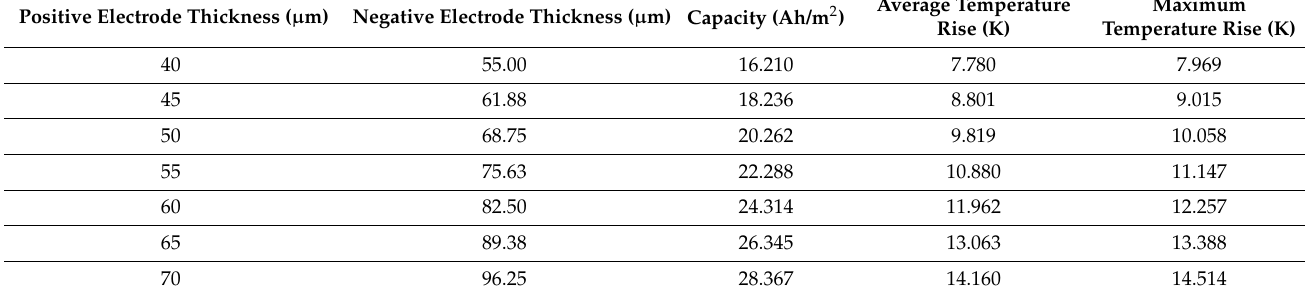
Table 3. Effect of electrode thickness on